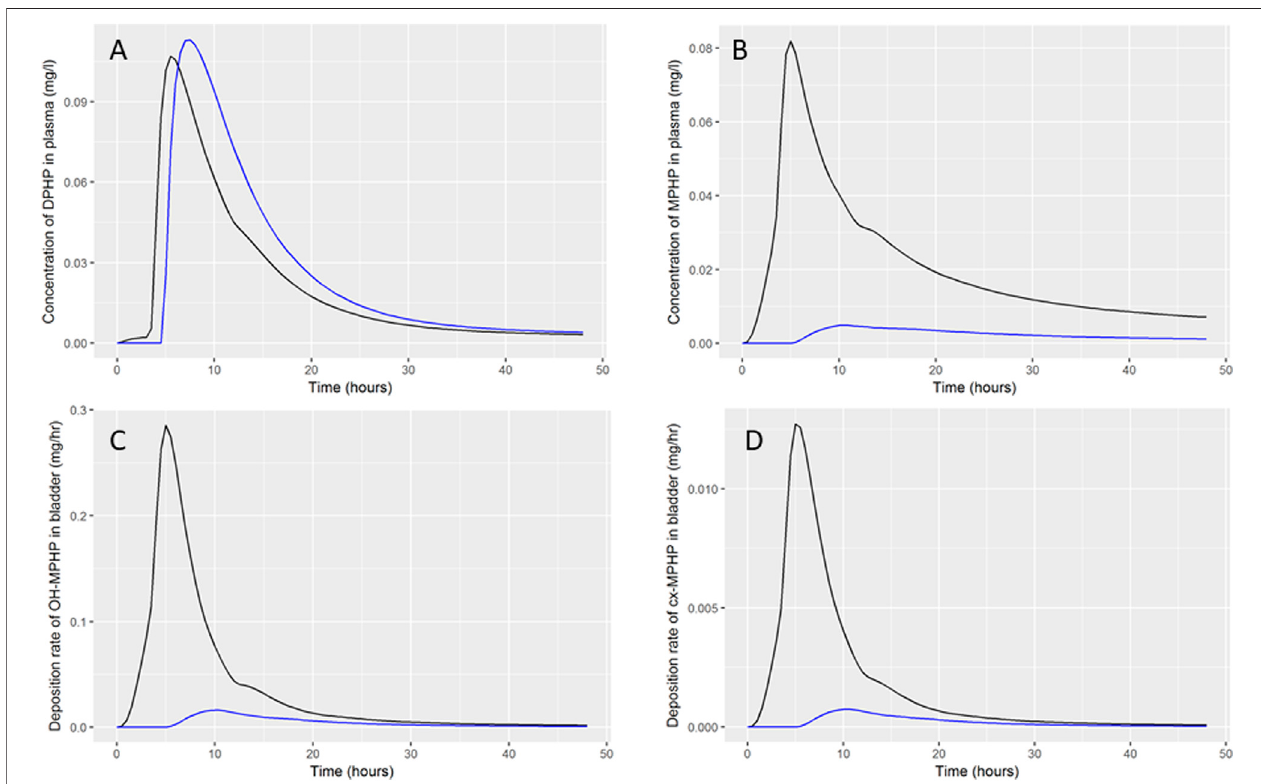
FIGURE 9 | Comparison of DPHP hepatic and lymphatic routes of uptake. Simulations were based upon optimised parameters for individual A but where the lymphatic fraction (black lines) or the hepatic fraction (blue lines) was set to zero.